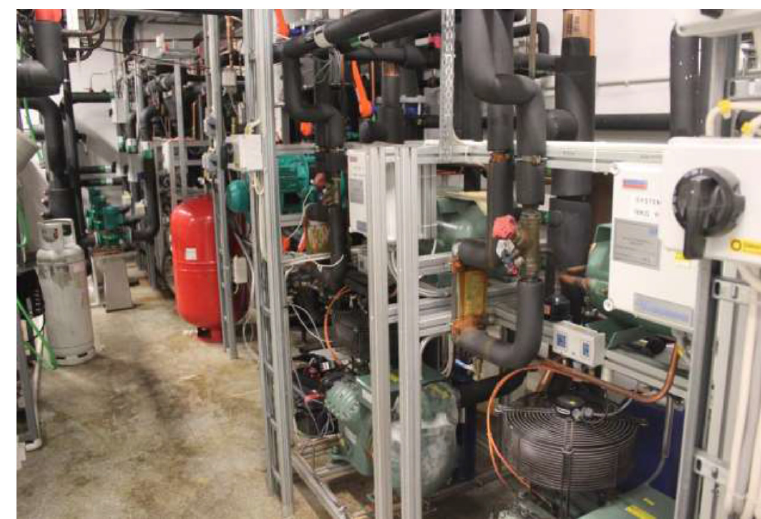
Figure 2. Supermarket refrigeration system used in this study.